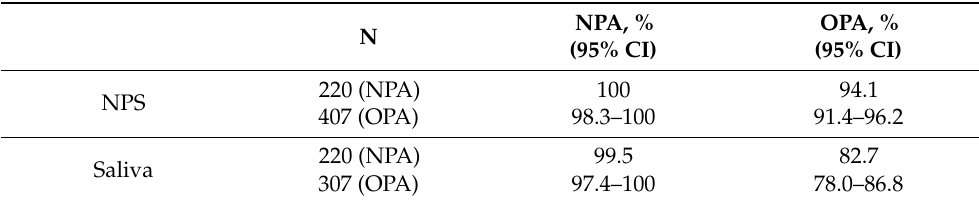
Table 3. NPA and OPA of the Roche Elecsys Anti-SARS-CoV-2 Antigen assay with the Roche cobas SARS-CoV-2 IVD test.